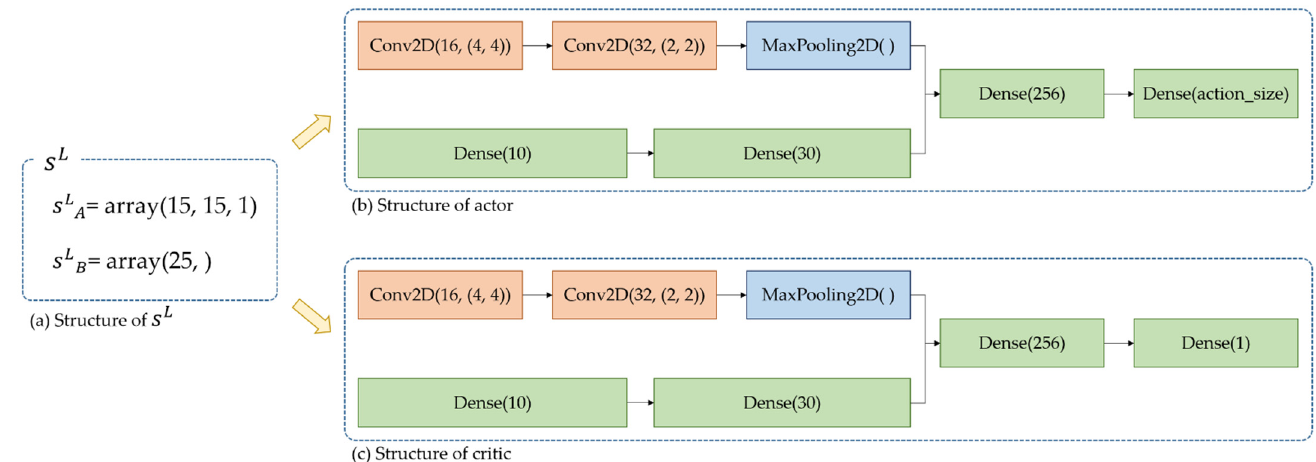
Figure 3. Structure of the A3C model: ( a ) structure of s L , ( b ) structure of actor, and ( c ) structure of critic.